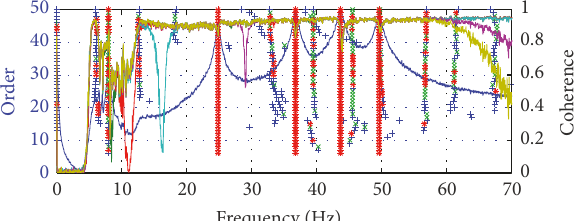
Figure 4: Stability diagram ( ∗ , frequency and damping stability poles; × , frequency stability poles; +, new poles).